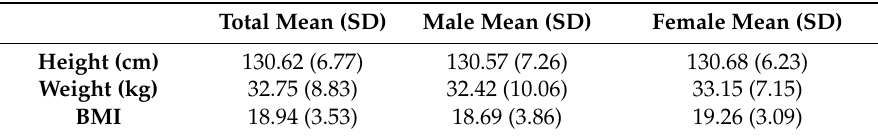
Table 1. Participant